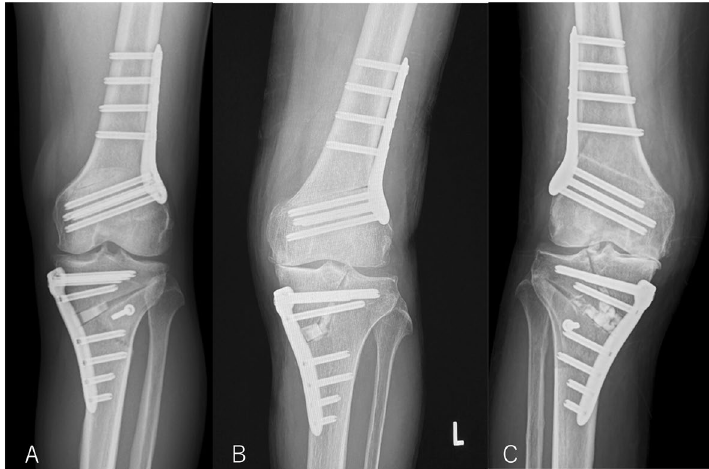
Fig. 2 Postoperative weight-bearing anteroposterior radiographs after DLO, A: LCW-DFO C: LCW-DFO TCVO OWDTO (right knee), DLO: double level osteotomy, LCW-DFO: lateral closed-wedge distal femoral osteotomy, TCVO: tibial + + condylar valgus osteotomy, OWDTO: open wedge distal tuberosity